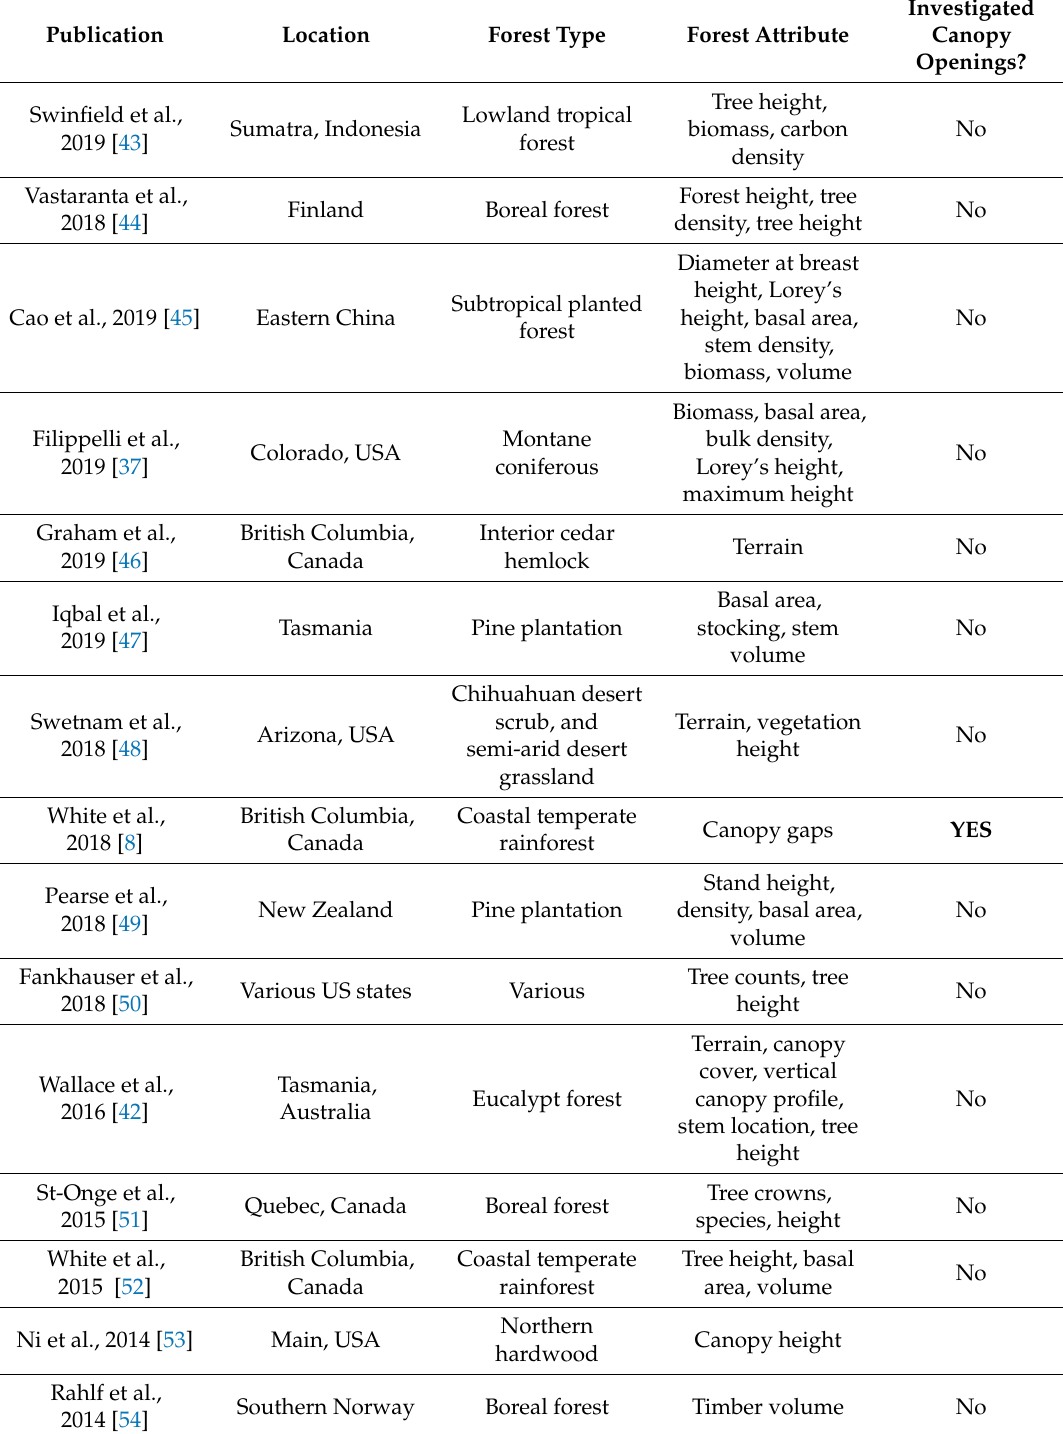
Table 1. A summary of recent (circa ~10 years) studies comparing forest-structure information derived from light detection and ranging (LiDAR) and digital airborne photogrammetry (DAP) reveals the dearth of research assessing canopy openings directly. This is not intended to be an exhaustive